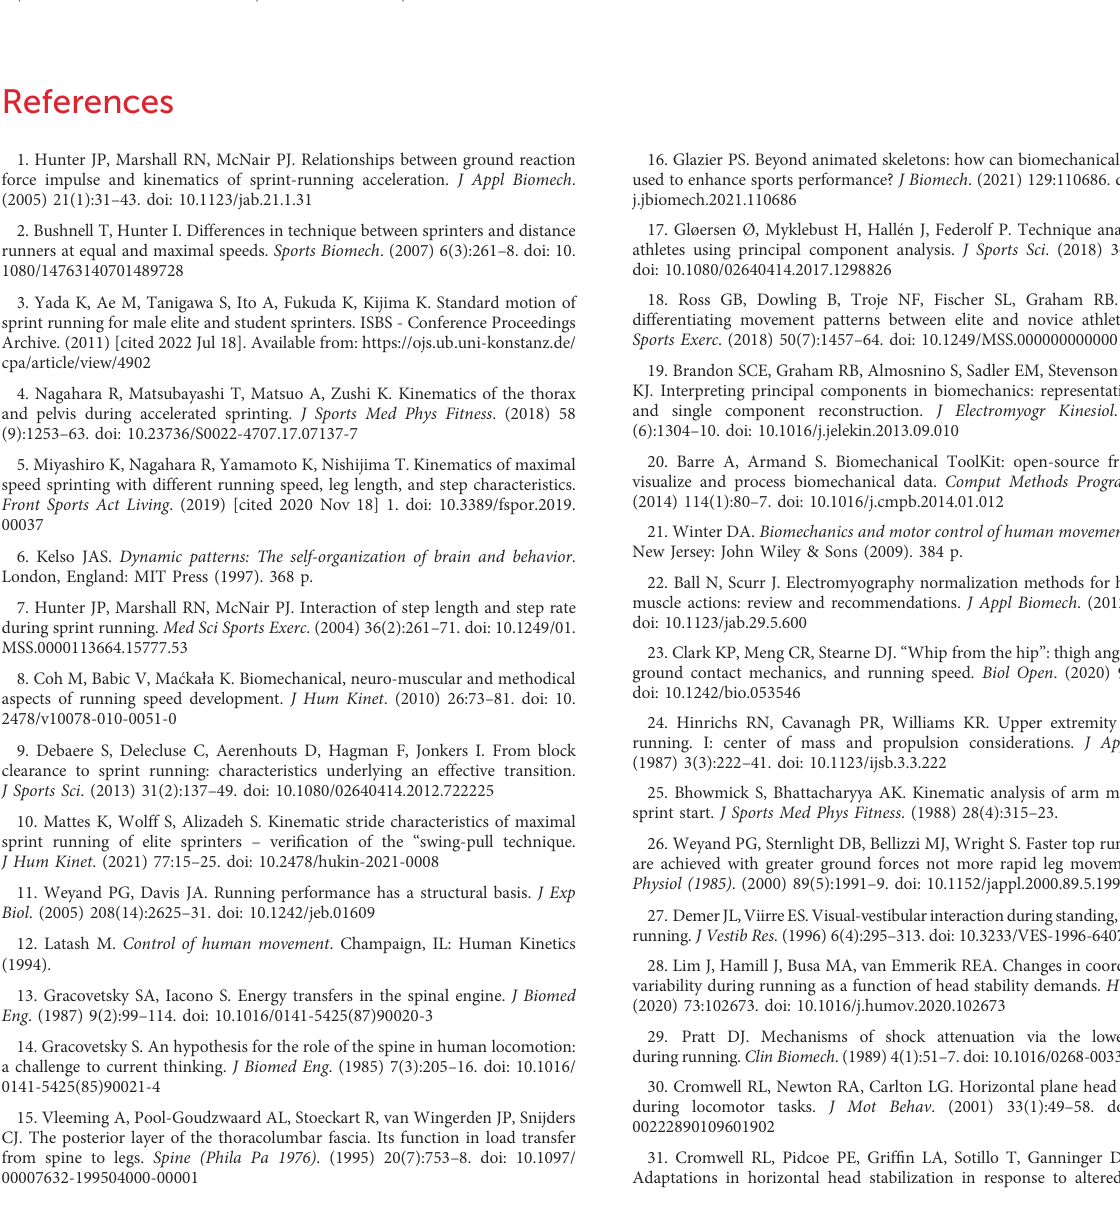
SUPPLEMENTARY FIGURE S9 SCR for PC 1 the blue line represents a muscle activation pattern associated with faster sprint velocities, a red line is associated with slower sprint velocities, and black represents the mean. SUPPLEMENTARY FIGURE S10 SCR for PC 5 the blue line represents a muscle activation pattern associated with faster sprint velocities, a red line is associated with slower sprint velocities, and black represents the mean. SUPPLEMENTARY FIGURE S11 SCR for PC 21 the blue line represents a muscle activation pattern associated with faster sprint velocities, a red line is associated with slower sprint velocities, and black represents the mean. SUPPLEMENTARY FIGURE S12 SCR for PC 22 the blue line represents a muscle activation pattern associated with faster sprint velocities, a red line is associated with slower sprint velocities, and black represents the mean. Supplementary Table S1 Summary of Residual Analysis